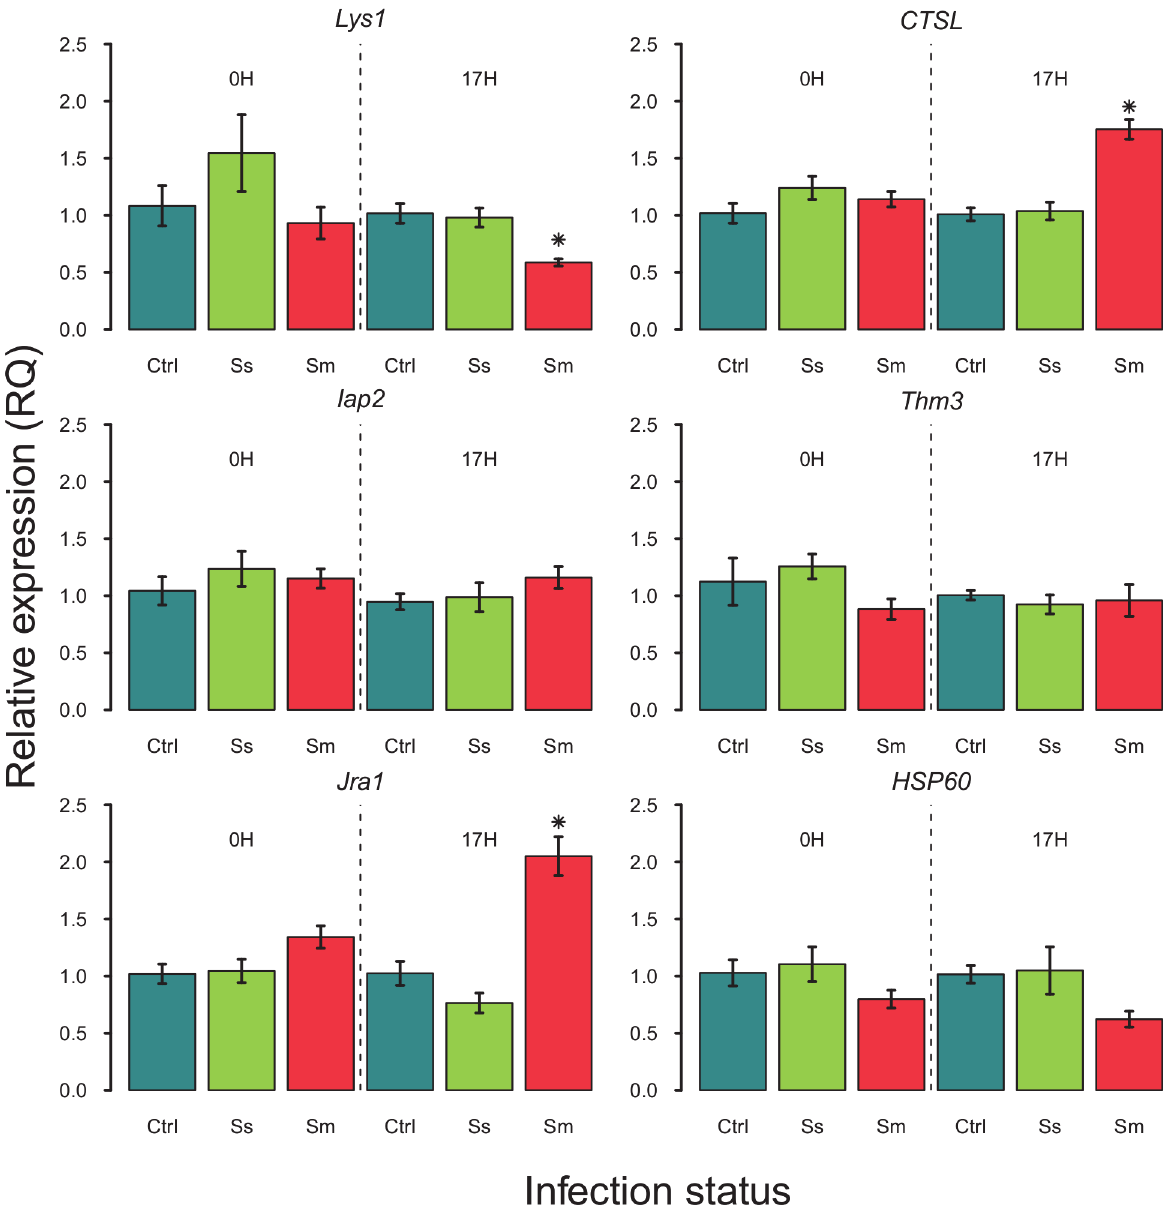
Fig 4. Quantitative real-time RT-PCR analysis of transcriptional levels of six selected A . pisum genes in response to bacterial infection. The mRNA levels of selected genes in infection with S . symbiotica CWBI-2.1 T (green), S . marcescens Db11 (red) were determined and are shown relative to their expression levels in untreated insects (blue). The expression level was normalized by comparative C T ( ΔΔ C T ) method using ef1- α as reference gene. Columns and bars indicate means and standard